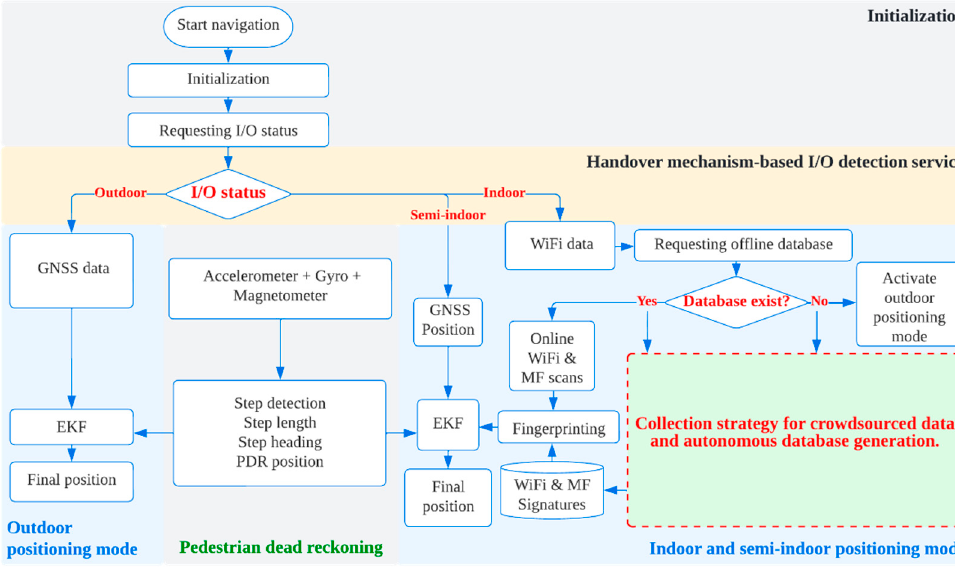
Figure 3. Schematic diagram of the proposed seamless and ubiquitous navigation system.